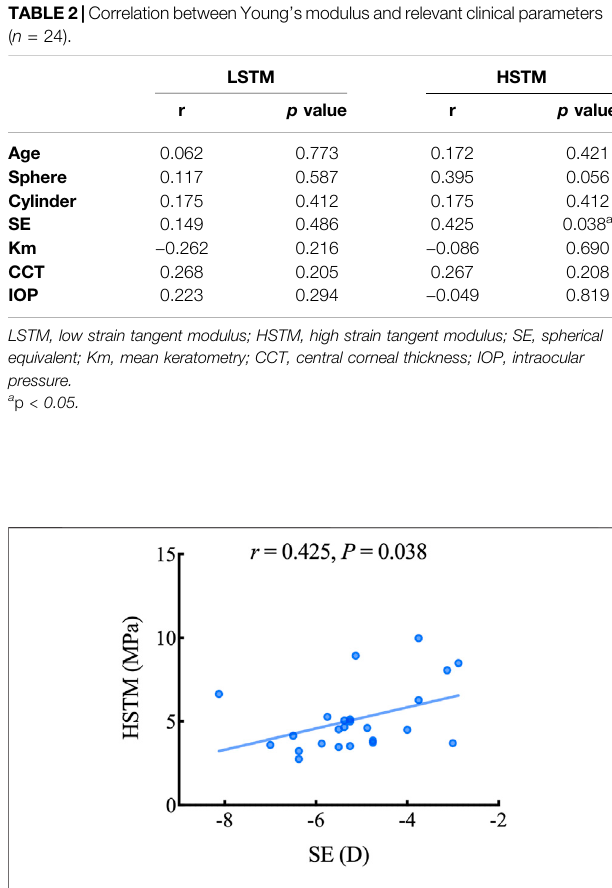
TABLE 2| Correlation betweenYoung ’ smodulusandrelevantclinicalparameters ( n = 24).